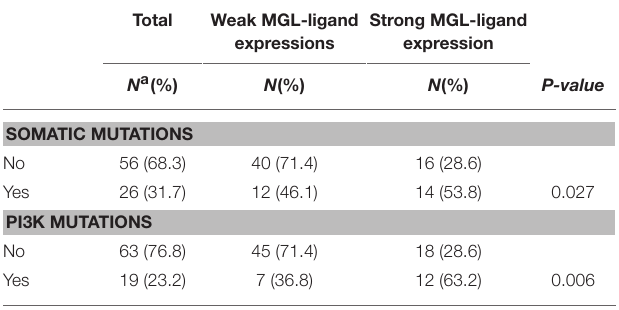
TABLE 2 | MGL ligand expression in relation to mutational